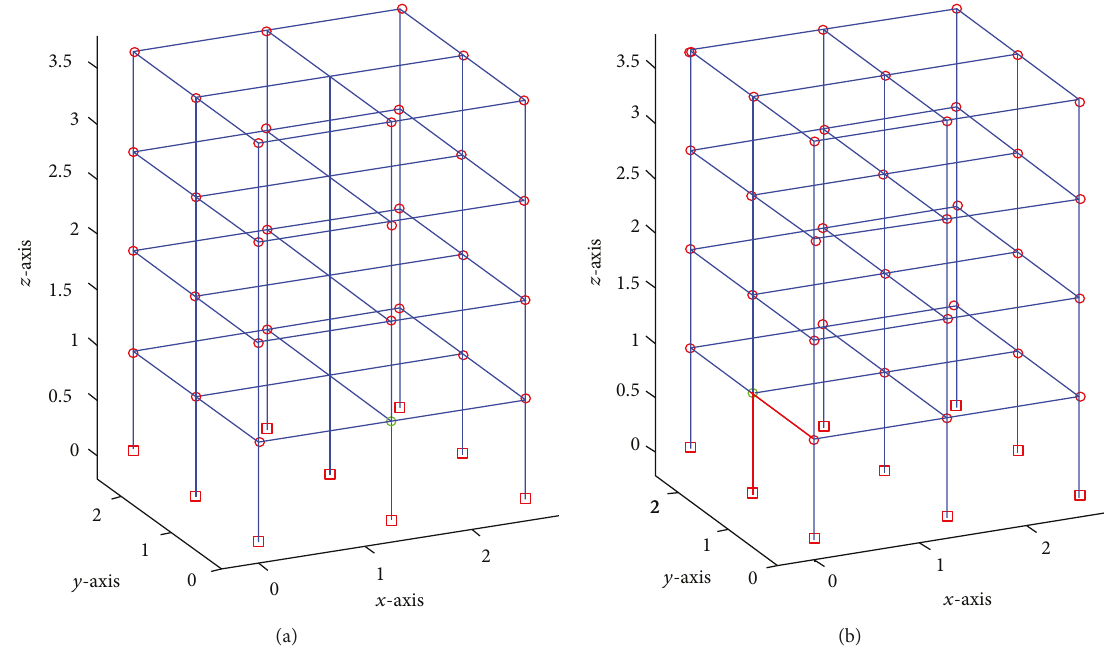
Figure 11: Incomplete MSs damage scenarios: (a) scenario 3 and (b) scenario